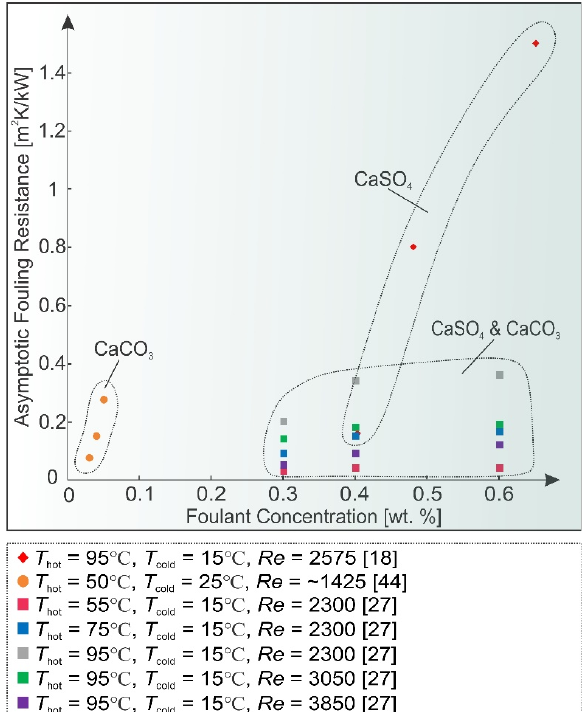
Figure 4. Foulant concentration effect on asymptotic fouling resistance values.